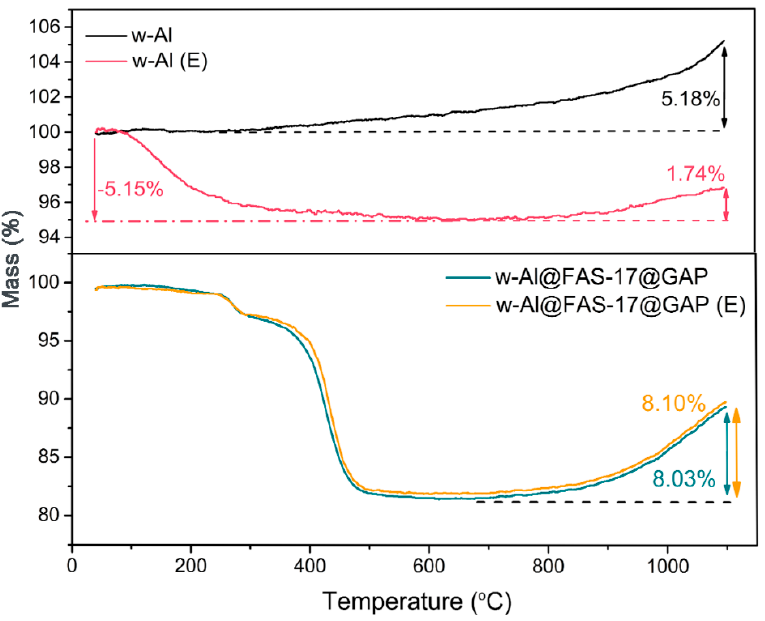
Figure 6. Comparison of TGA curves for environmental adaptability of w-Al and w-Al@FAS-